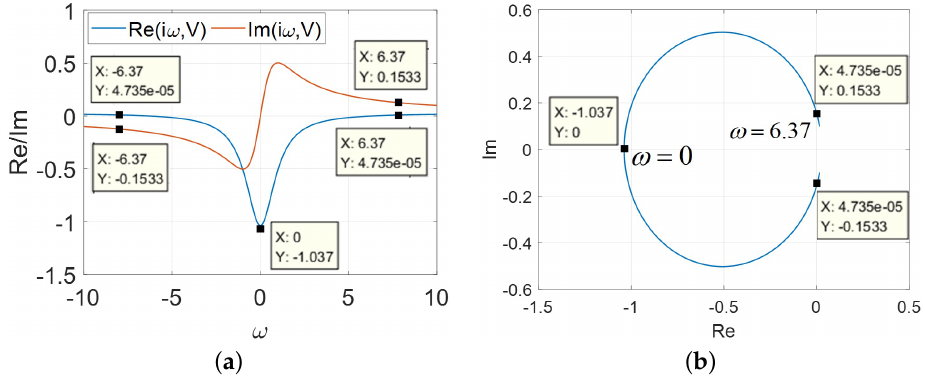
Figure 14. The frequency response, A = A M : ( a ) Re [ Y ( i ω , V )] and Im [ Y ( i ω , V )] over the ranges − 10 < ω ∗ < 10; ( b ) Re [ Y ( i ω ∗ , V )] vs . Im [ Y ( i ω ∗ , V )]